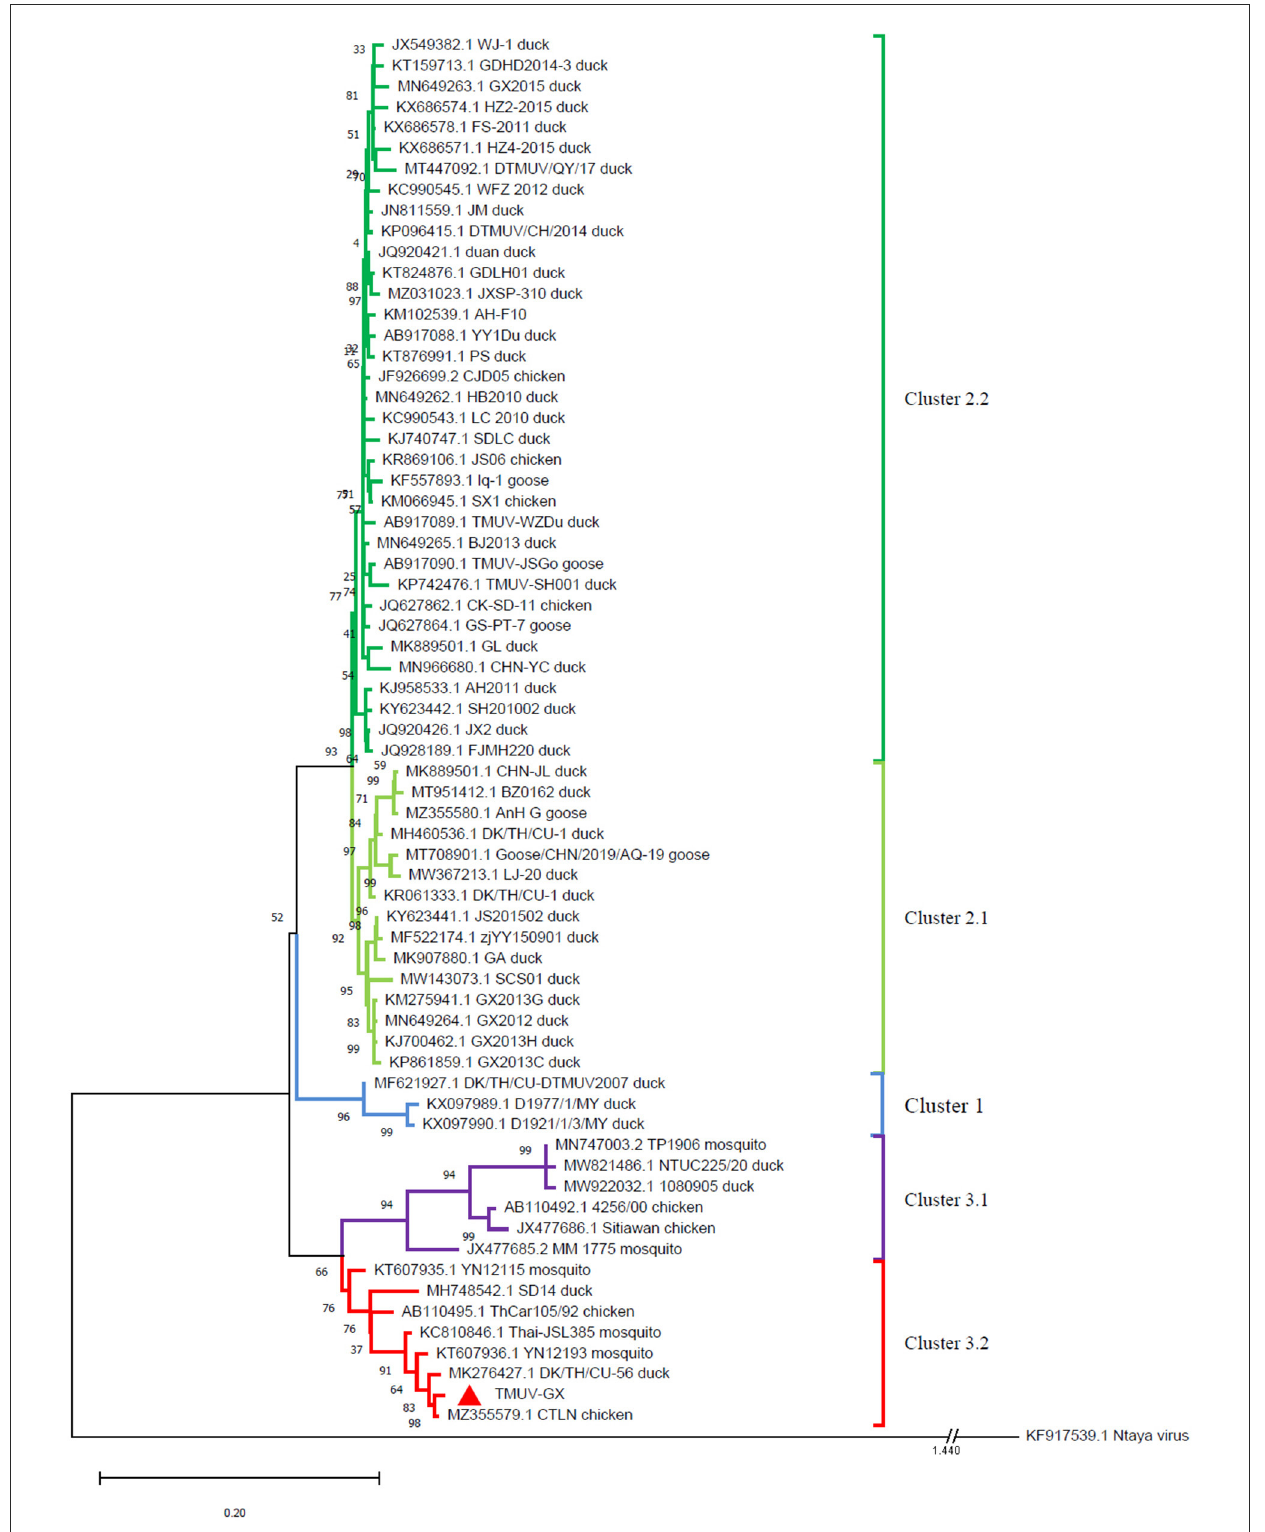
FIGURE2 Phylogenetic analysis based on the E genes of TMUVs. The phylogenetic tree was generated via the ML method implement on MEGA v.7.0. Bootstrap values are shown at the nodes. The Ntaya isolate was used as the outgroup.